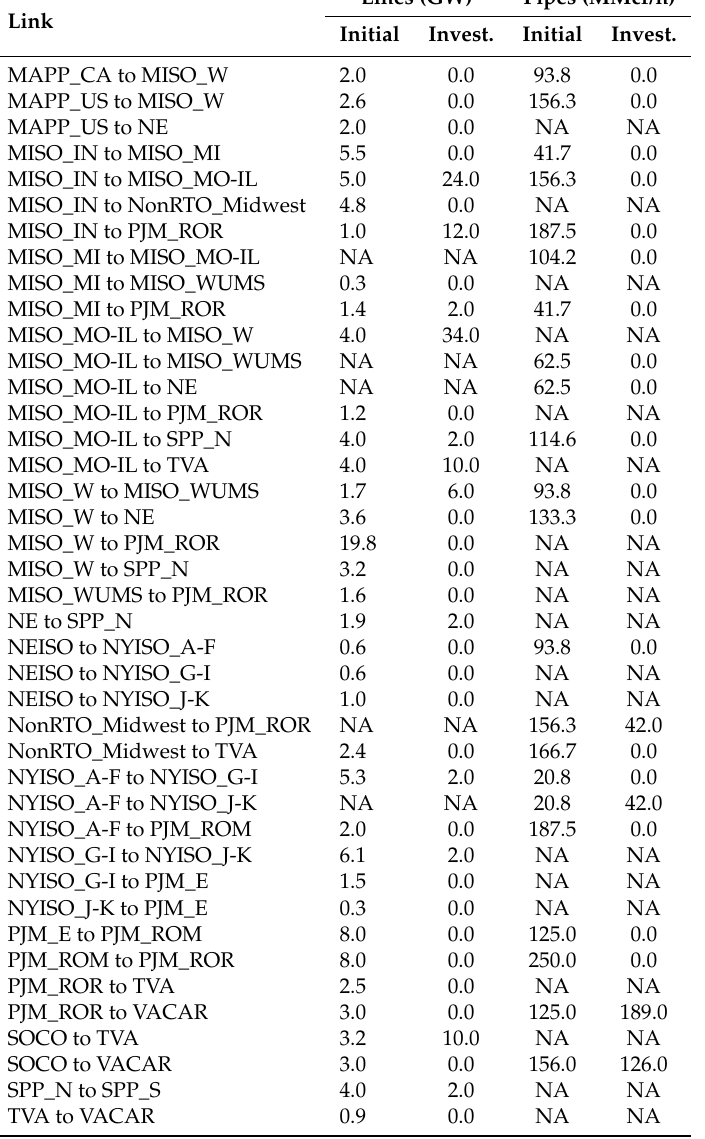
Table 3. Transportation initial capacity and investments (continuation).